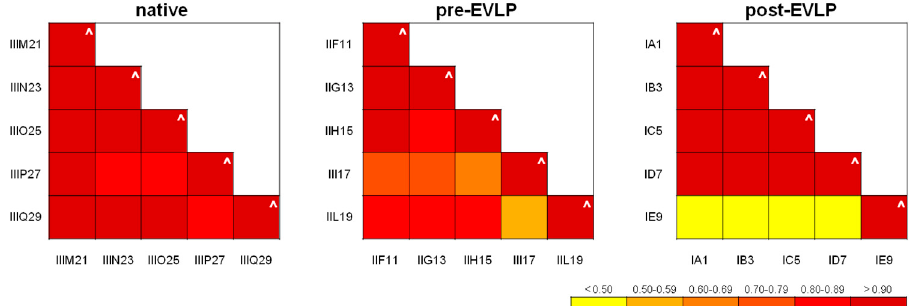
Figure 3. Technical and biological repeatability of proteomic analysis. Diagrams of correlation coefficient (R2) values of technical and biological replicates. Each R2 value of technical and biological replicates was assigned a color code, and the corresponding ranges associated to a chromatic scale were reported. The technical R2 value (^) was obtained comparing the spectral count (SpC) values from two runs of the same sample. Similarly, plotting the average SpC* values of two samples belonging to the same condition the biological R2 value was calculated. The numerical linear regression values (R2) for each comparison are reported in Supplementary Table S3.